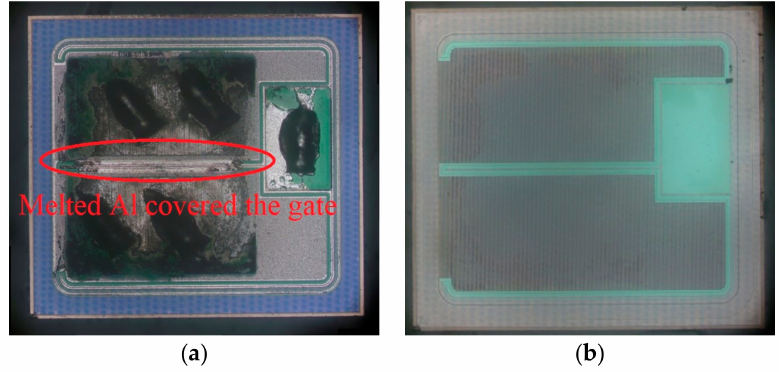
Figure 11. The anatomy results of Cree device C2M0160120D ( a ) decapping, ( b ) removing layers to the substrate